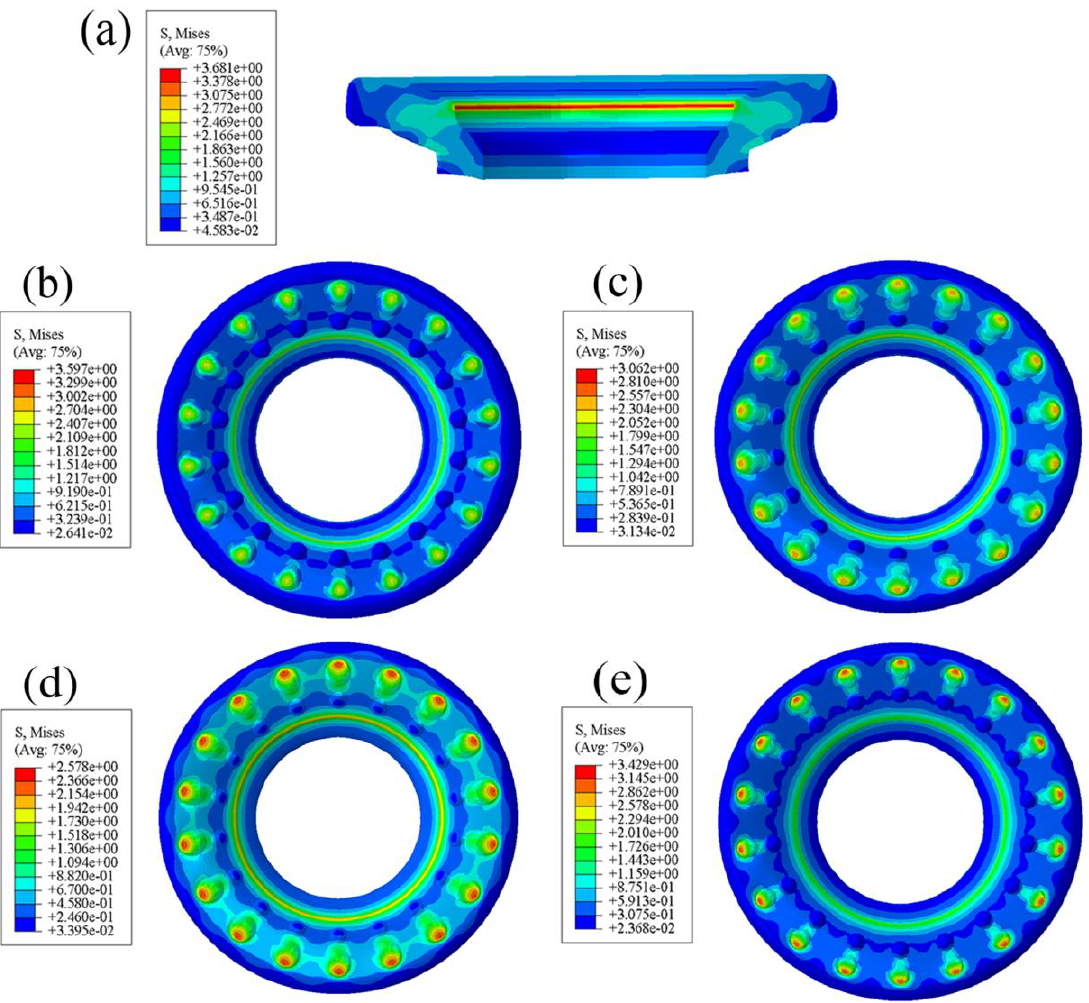
Figure 12. Diagram of contact equivalent stress: ( a ) section of standard bushing; ( b ) type1; ( c ) type2; ( d ) type3; ( e ) type4.